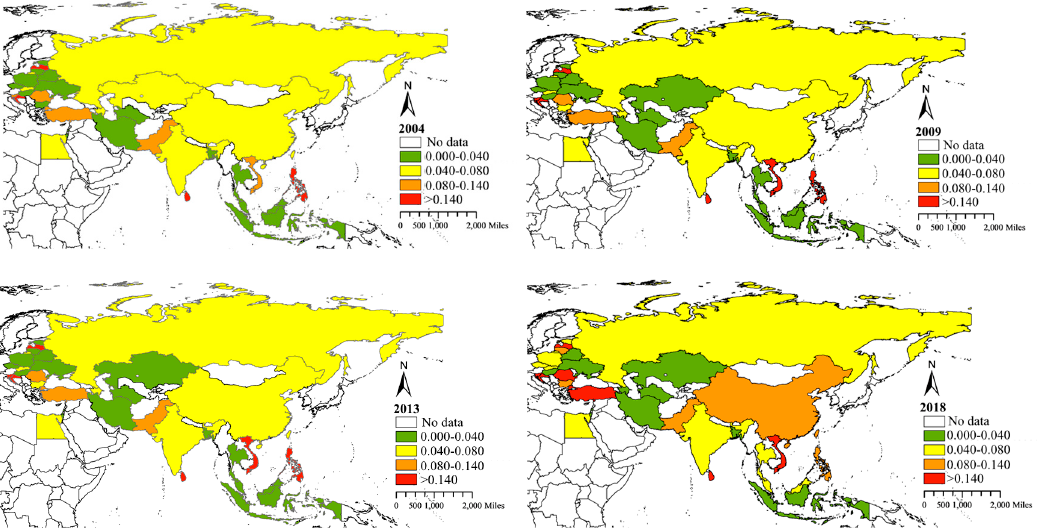
Figure 1. Share of renewable energy consumption in Belt and Road Initiative (BRI) countries.